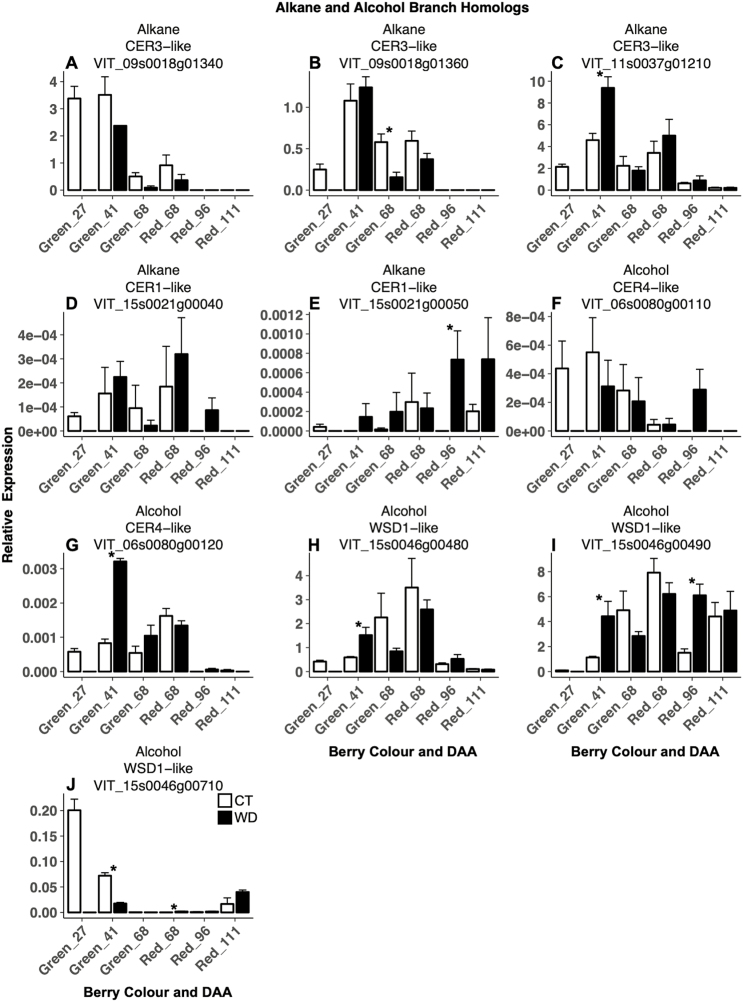
Expression of candidate genes involved in the alcohol- and alkane-forming branches of the biosynthetic cuticular wax pathway in berry skins of grapevines (Vitis vinifera L.) exposed to two irrigation treatments: well-irrigated (control, CT) and deficit irrigated (water deficit, WD). Error bars represent ±SE, and significant differences between treatments were determined by two-sample t-test (*P<0.05).